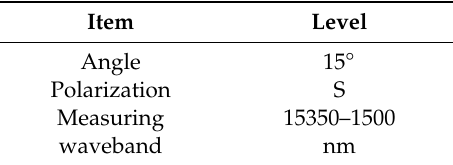
Table 9. Spectrophotometer parameters.